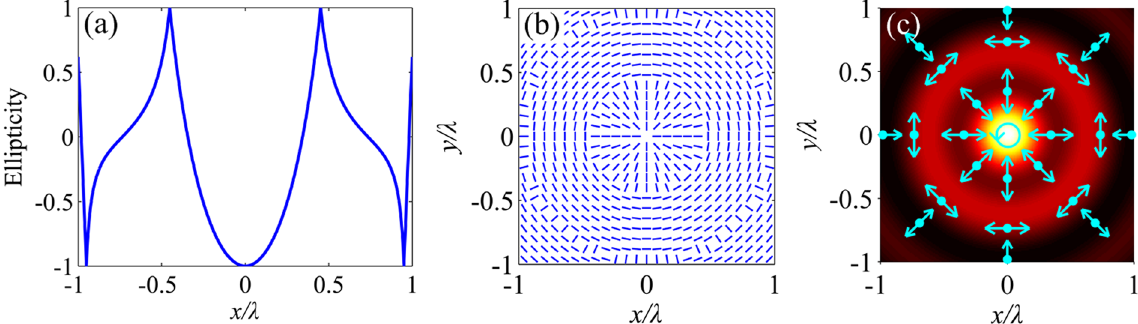
Figure 3. Polarization of the electric field on the focal plane of the first-order SZP illuminated by an AP Bessel- Gaussian beam. ( a ) Ellipticities tan χ of the local polarization ellipses along the x- axis. ( b ) Orientations of the long axes of the local polarization ellipses on the focal plane. ( c ) Polarization directions at particular positions on the focal plane.